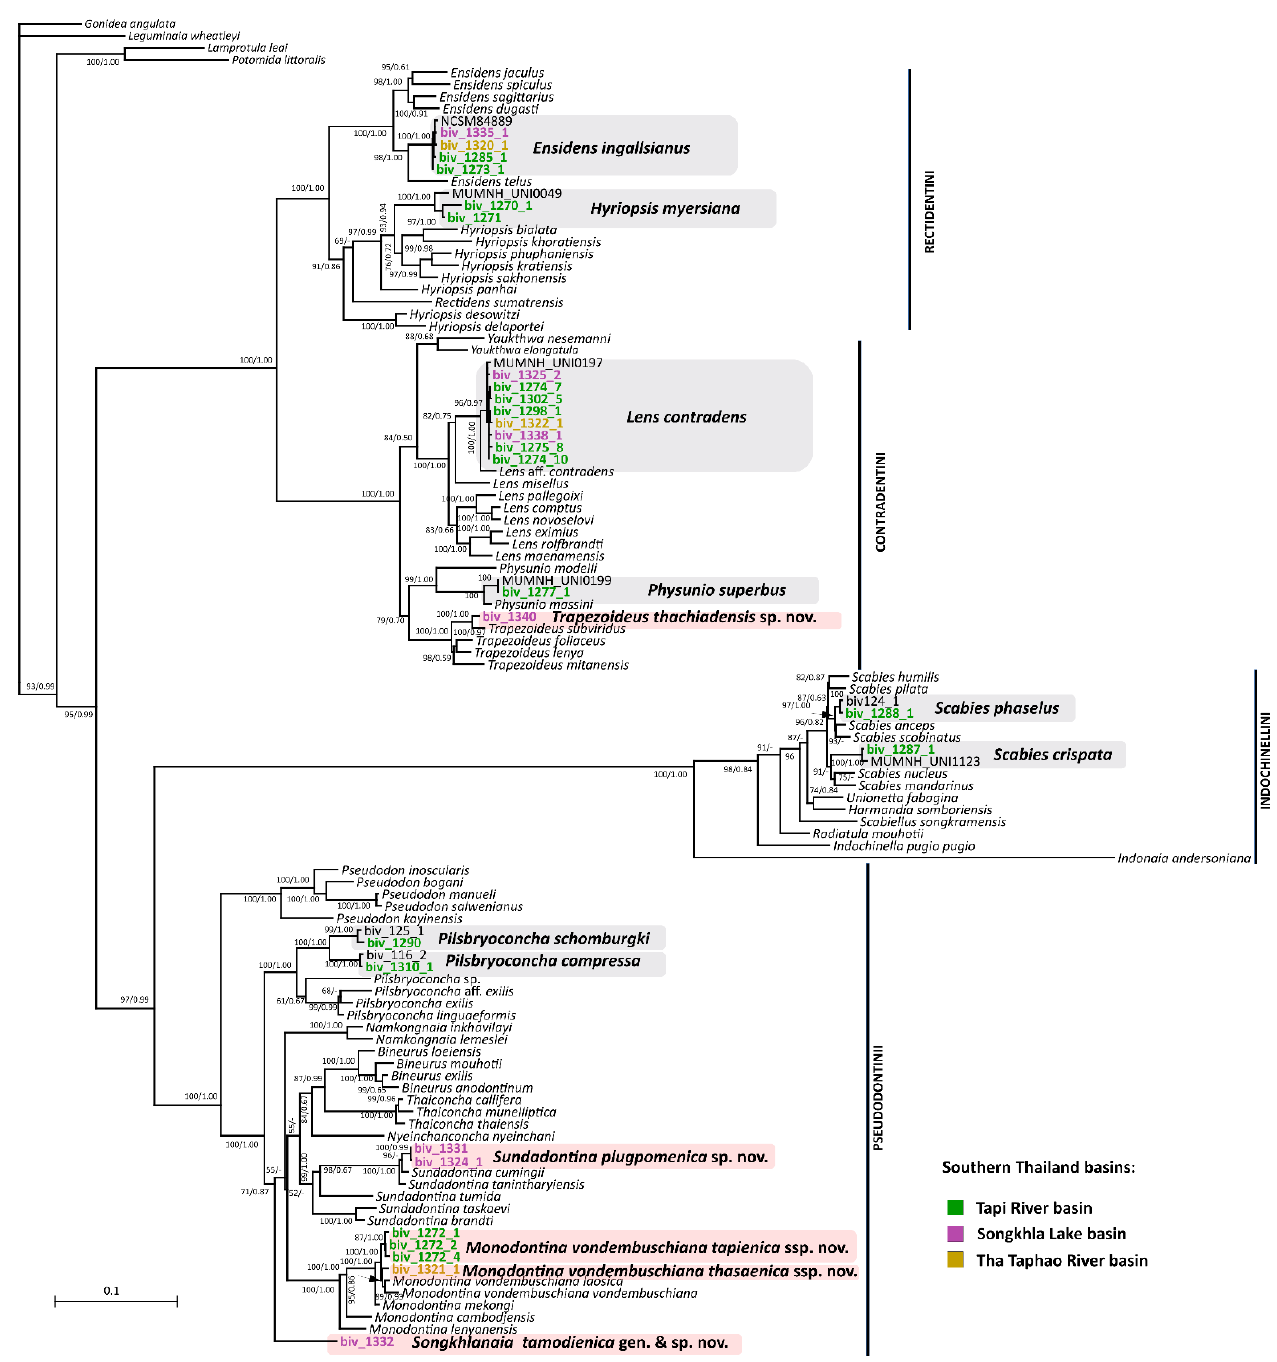
Figure 8. Maximum likelihood phylogeny of the complete data set of mitochondrial and nuclear sequences (five partitions: three codons of COI + 16S rRNA + 28S rRNA ) of the Unionidae from Southeast Asia, including available taxa from Southern Thailand (highlighted by grey rectangles). New taxa from Southern Thailand are marked by pink rectangles. The scale bar indicates the branch lengths. Black numbers near nodes or arrowed are ML ultrafast bootstrap support values (BS)/Bayesian posterior probabilities (BPP).